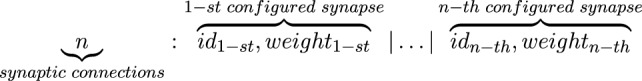
Structure of the derived word for presynaptic connections of a neuron.